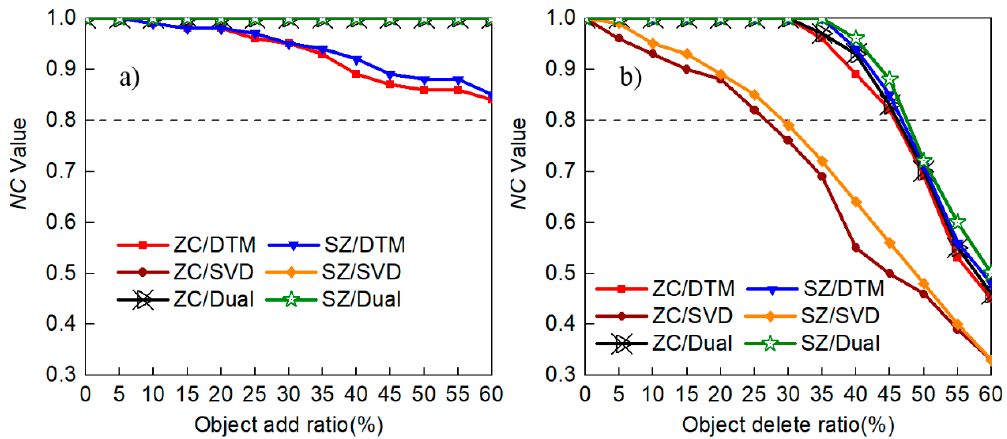
Figure 7. The NC change curves under increased levels of ( a ) object addition and ( b ) object deletion.